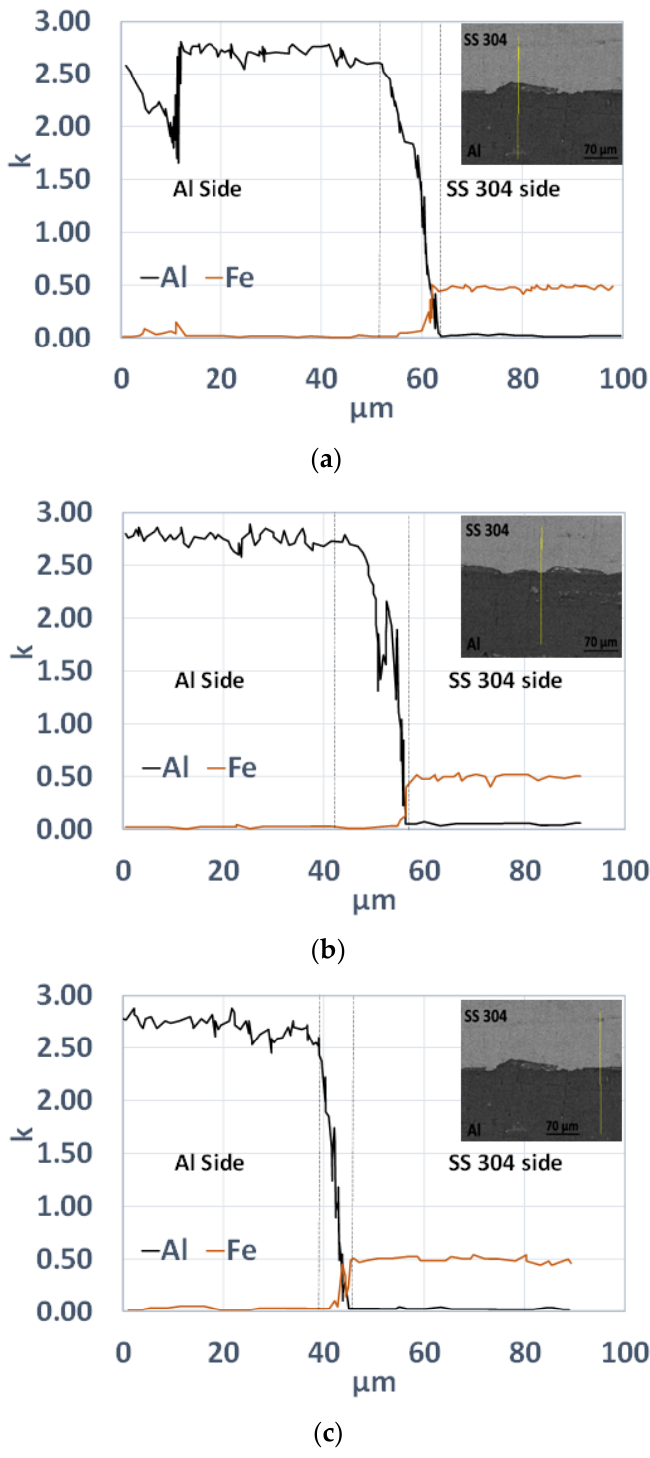
Figure 11. EDS line scan at ( a ) crest of a wave, ( b ) trough of a wave, ( c ) flat interface.